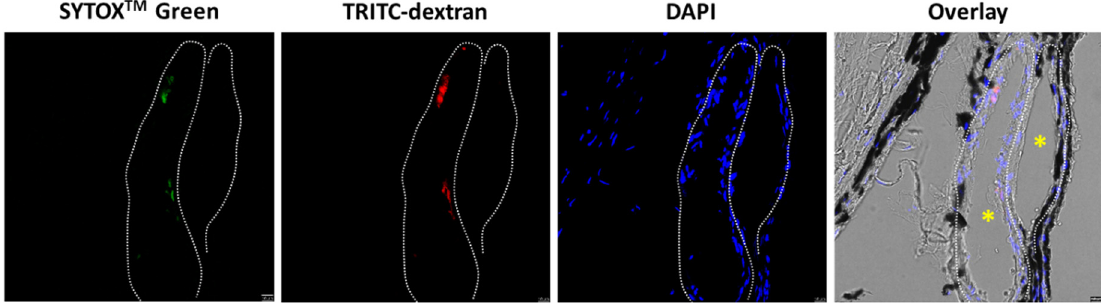
Figure 7. Example of induced intracellular accumulation in cells lining blood vessels in the choroid after treatment with USMB at MI 0.4. Yellow asterisks in the overlay image indicate the lumen of choroidal blood vessels. White dotted line indicates the area of cells lining the blood vessel lumen. Overlay image is a combination of fluorescent and phase contrast images. Green is indicated by the “SYTOX Green name”. TRITC and DAPI are widely used fluorophores with red and blue colors, respectively. Scale bar: 10 μ m.